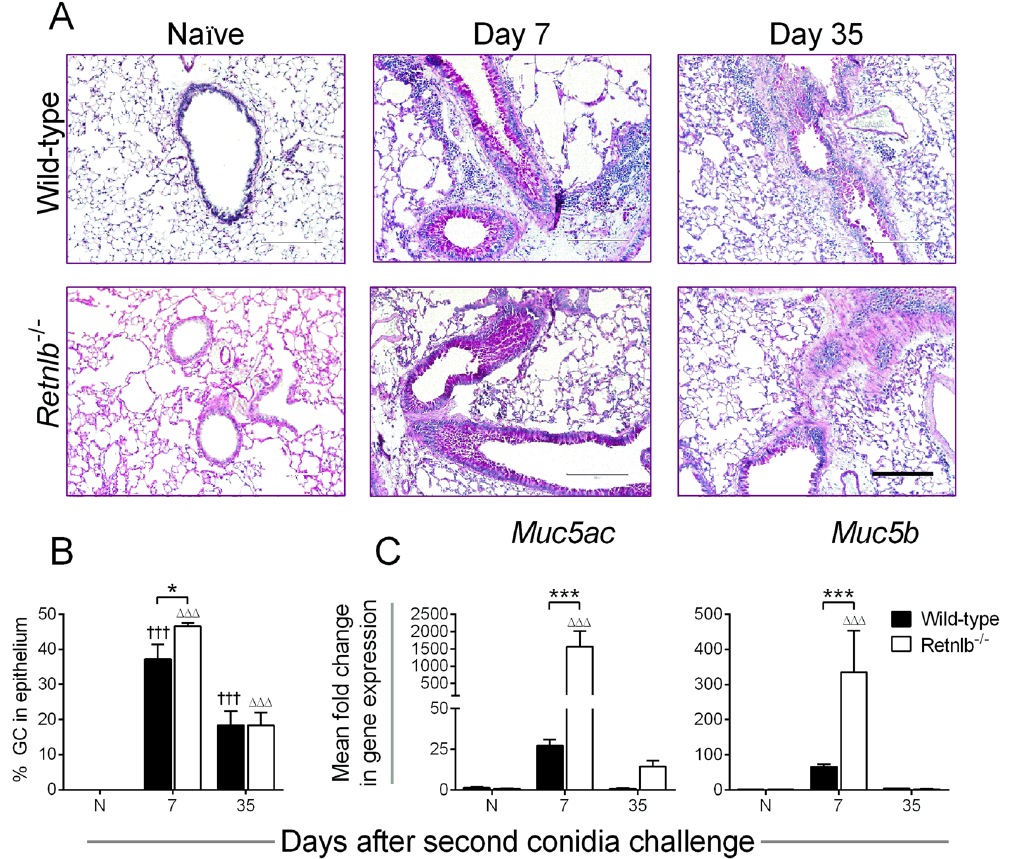
Figure 4. RELM- β inhibits goblet cell (GC) differentiation and Muc gene expression. Goblet cells were not observed in the naïve (N) controls of either genotype but were abundant in the airway lining after allergen exposure ( A ). While GCs consisted of approximately 40% of the epithelial lining in both genotypes at the early time point, these cells reduced over time to only about 20% at the late time point ( B ). More GCs were present in the airways of Retnlb − / − mice at Day 7 ( B ), corresponding with greater expression of mucus genes, Muc5ac and Muc5b ( C ). Scale bar = 200 µ m applicable to all photo micrographs. Data are represented as the mean and SEM of n = 4–7 mice/group in one representative study of two independent studies. Data at each time point were compared by two-way ANOVA with Dunnett’s and Sidak’s multiple comparisons test to their naïve controls († and Δ ), and between genotypes ( * ) respectively. Three symbols represent P < 0.05 and P < 0.001